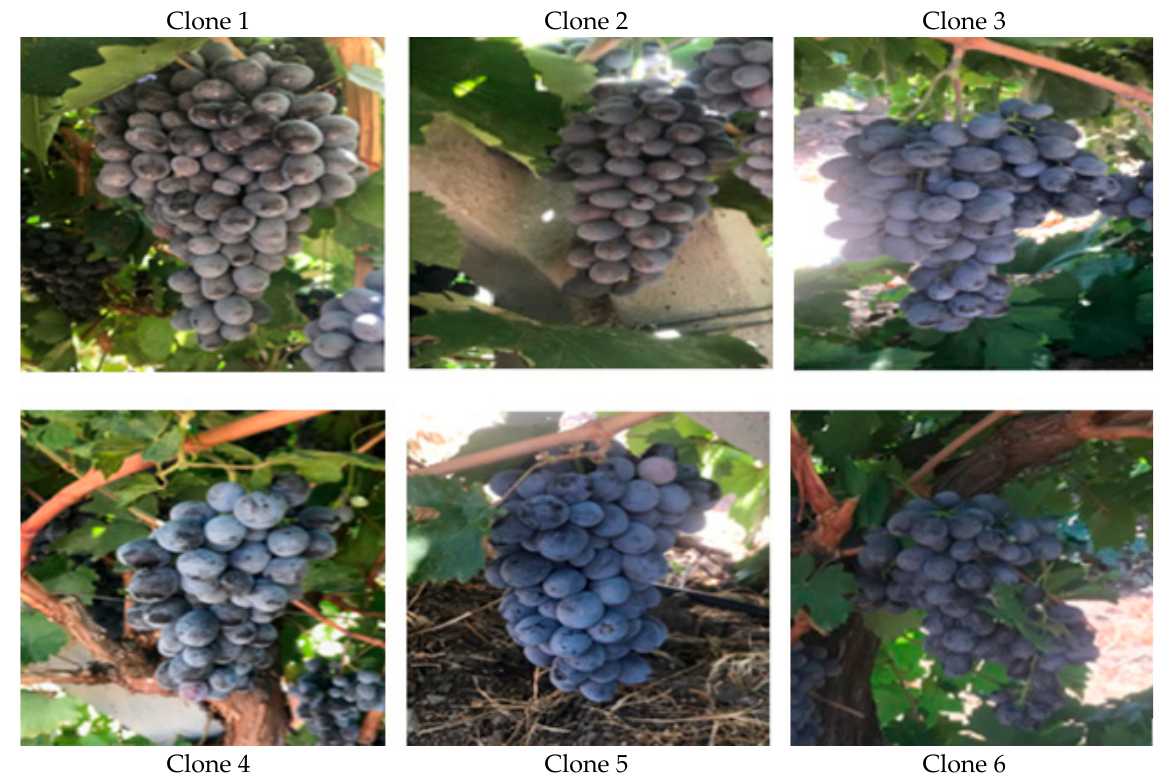
Different letters in the same column indicate significant differences ( p < 0.05).